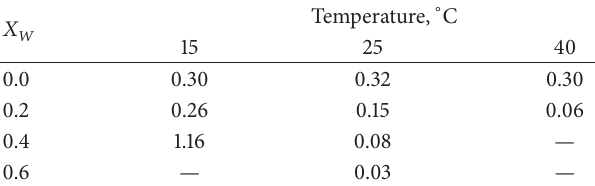
values from all experiments. PNT